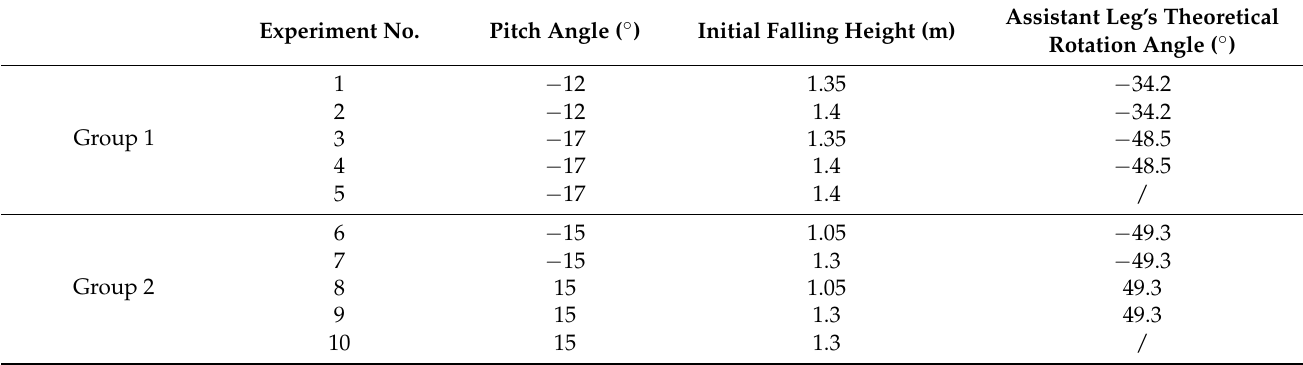
Table 2. The experimental scheme of aerial pitch control of jumping robot. Experiment No. Pitch Angle ( ◦ ) Initial Falling Height (m)